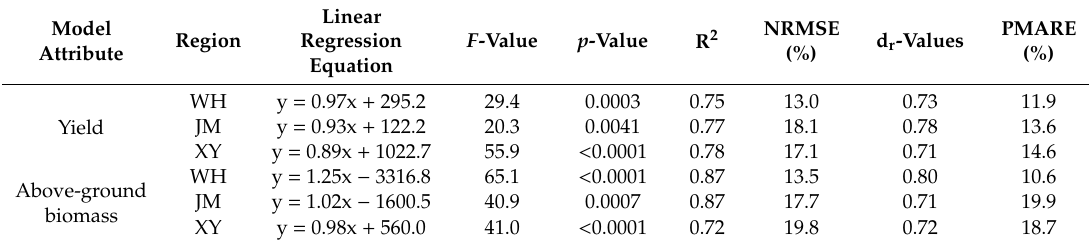
Figure 3. Relationships between the simulated and observed grain yield ( A ) and above-ground biomass ( B ) of winter wheat in the Wuhan (WH), Jingmen (JM), and Xiangyang (XY) regions in the Hubei province. Note: n means the number of paired data points. Some points overlap, so the actual number of points in some graphs di ff ers from the value of n. R 2 is presented for the fitted line. Table 7. The fitted equations for the linear relationships between the model-simulated and observed wheat grain yield and above-ground biomass and reliability measures: coe ffi cient of determination (R 2 ), normalized root mean square error (NRMSE), refined index of agreement (d r -values), and percent mean absolute relative error